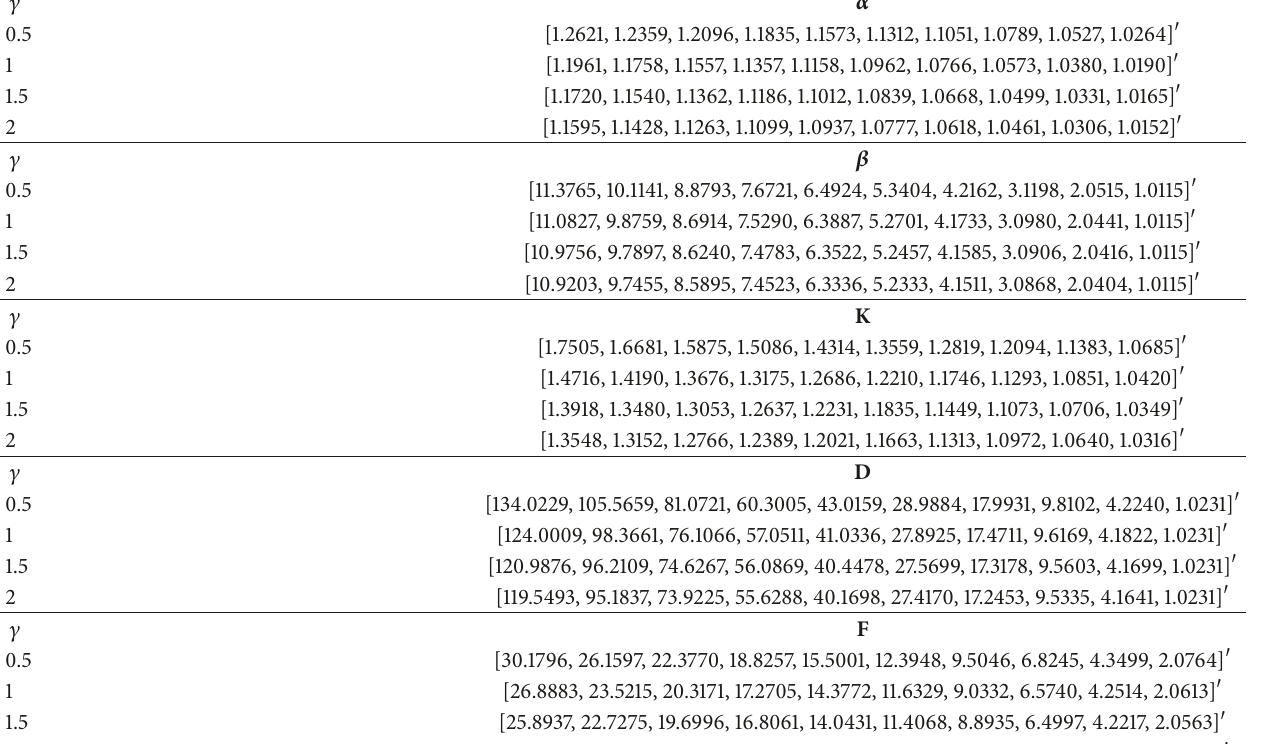
Table 1: Related parameter values under different risk aversion